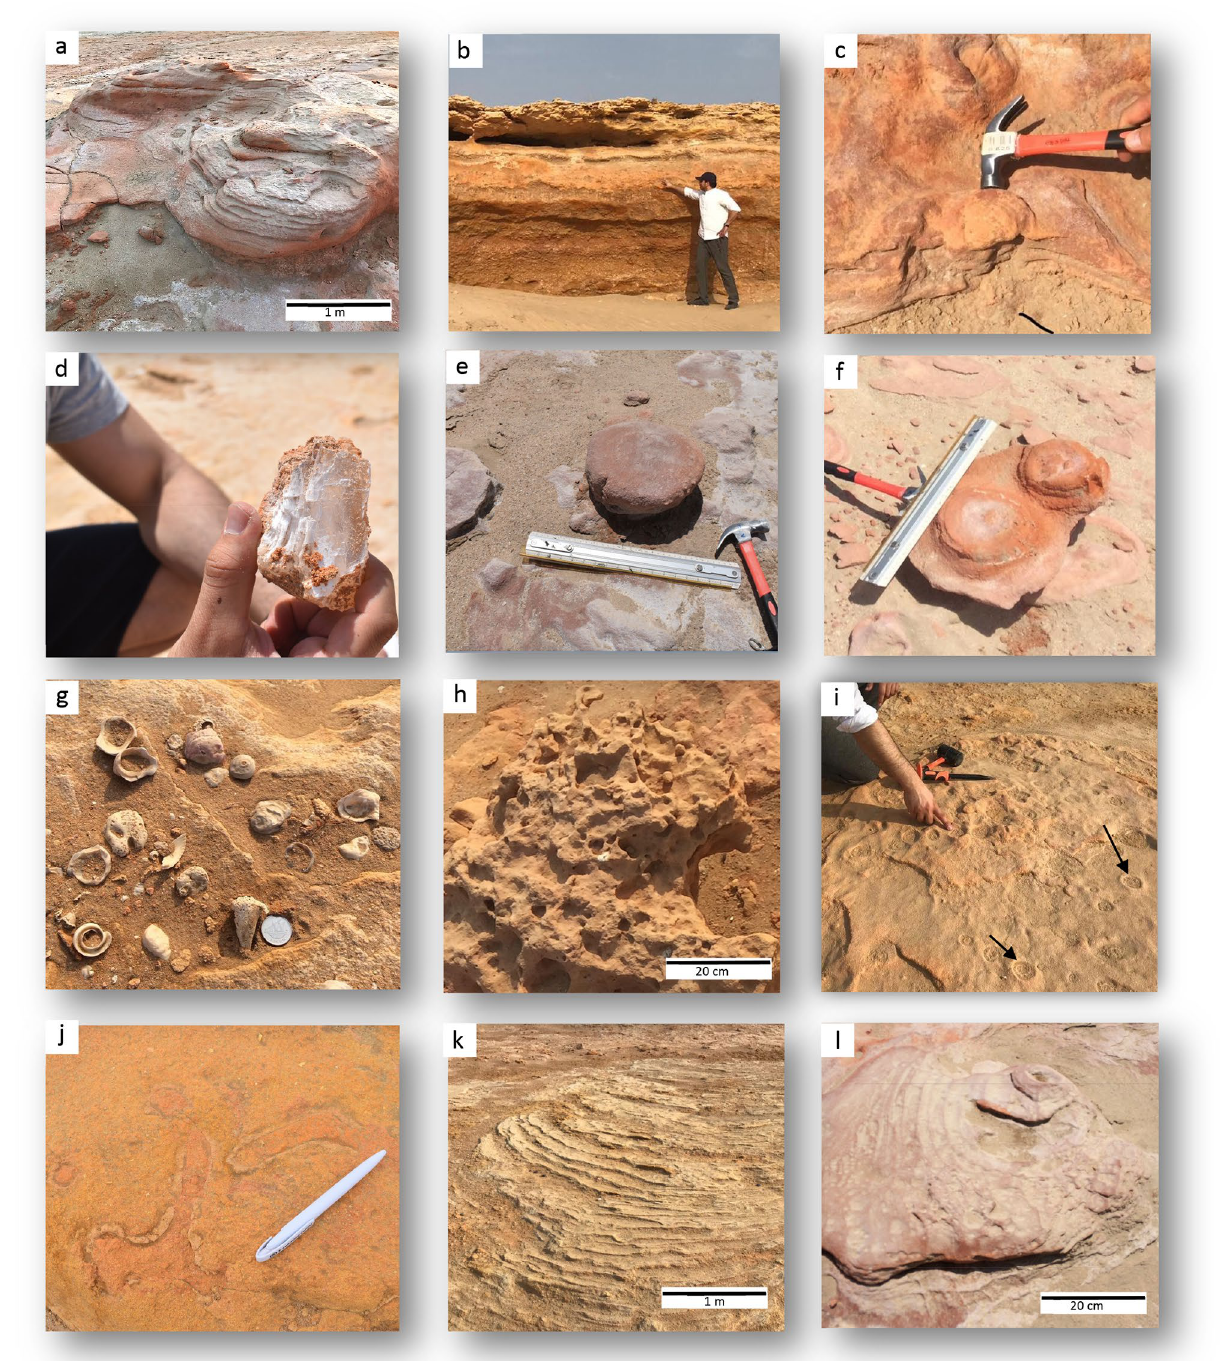
Figure 2. Features of the Miocene mud volcano field. ( a ) Large crater with concentrically developed banding; ( b ) Exposed Miocene strata showing 3 layers of; caliche in top, micro breccia in middle, and mega breccia at bottom; ( c ) Pipe-like structure with sandy matrix (MV1); ( d ) Evaporite megacrystic gypsum; ( e ) Concretion mound of (biogenic?) carbonate (MV2); ( f ) Lithified vents with regular annular radial pattern (MV3); ( g ) Original cover of Recent gastropod and bivalve shells on top of mud volcano outcrop; ( h ) Three-dimensional bioturbation network of Thalassinoides in carbonate rich breccia; ( i ) Surficial pockmarks pointed out by the arrows and are indicative of gas venting; ( j ) Ophiomorpha showing thick pelletoidal walls in evaporitic sandy matrix ( k ) Example of seismite, laminated sands and evaporites showing pseudo-bedding structures; ( l ) Weathered mixed breccia, concentric mound cemented by authigenic